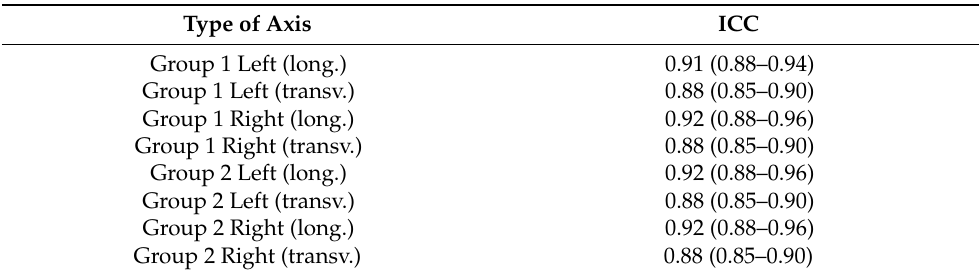
Table 6. Intra-rater reliability of the ultrasound TLF measurements within the different axes of group 1 and group 2. Type of Axis ICC Group 1 Left (long.)